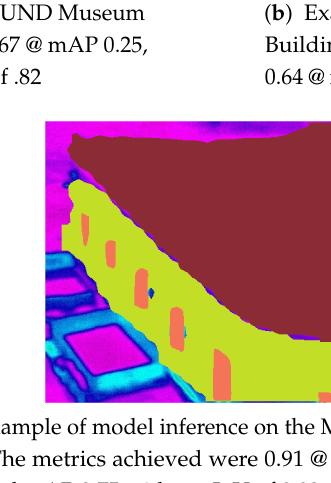
Figure 6. Examples of images of building segmented using Mask-RCNN trained on the heat loss